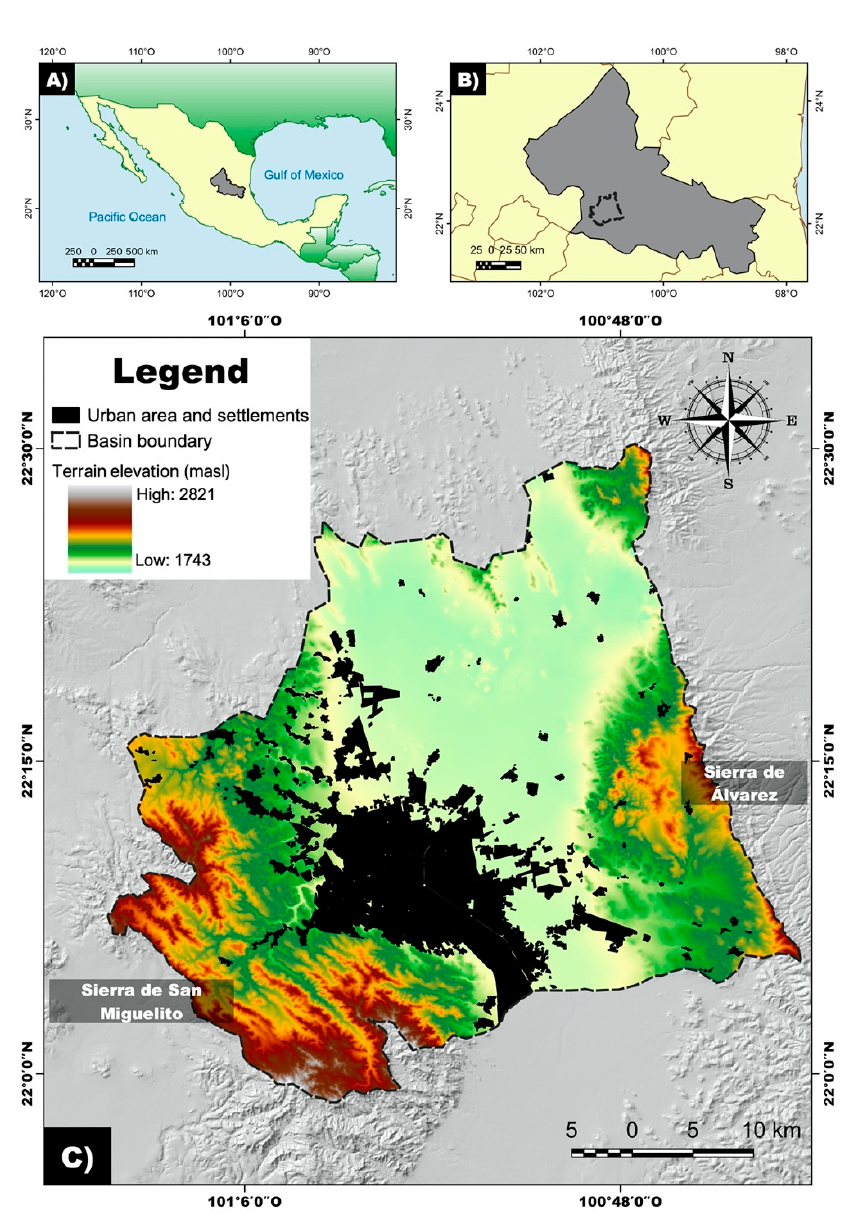
Figure 1. Location map of the study area. ( A ) Mexico; ( B ) San Luis Potosi State and ( C ) San Luis Potosi Basin.